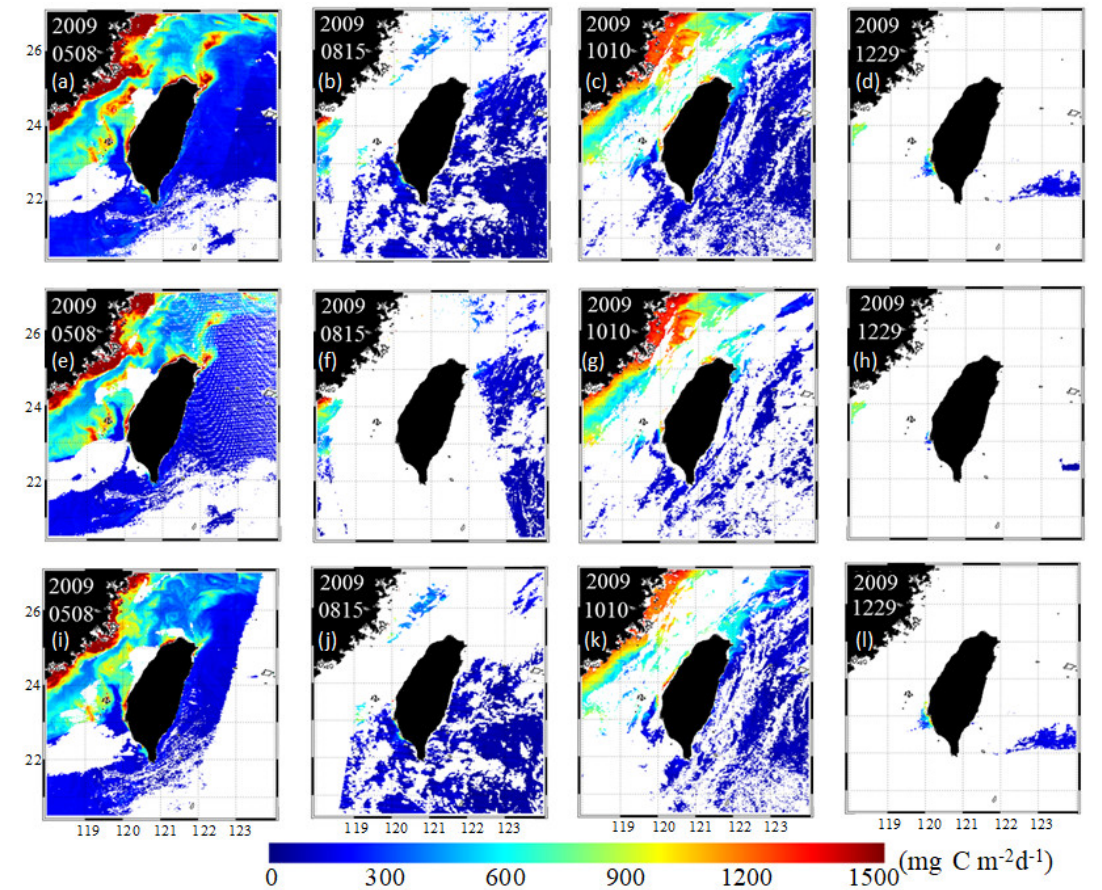
Figure 8. Daily spatial distribution maps of ( a – d ) PP A&T, (e–h) PP A , and ( e – h ) PP T in May, August, October, and December 2009.